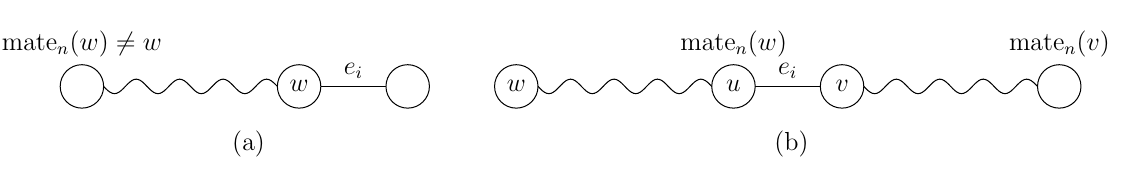
Figure 5. updating